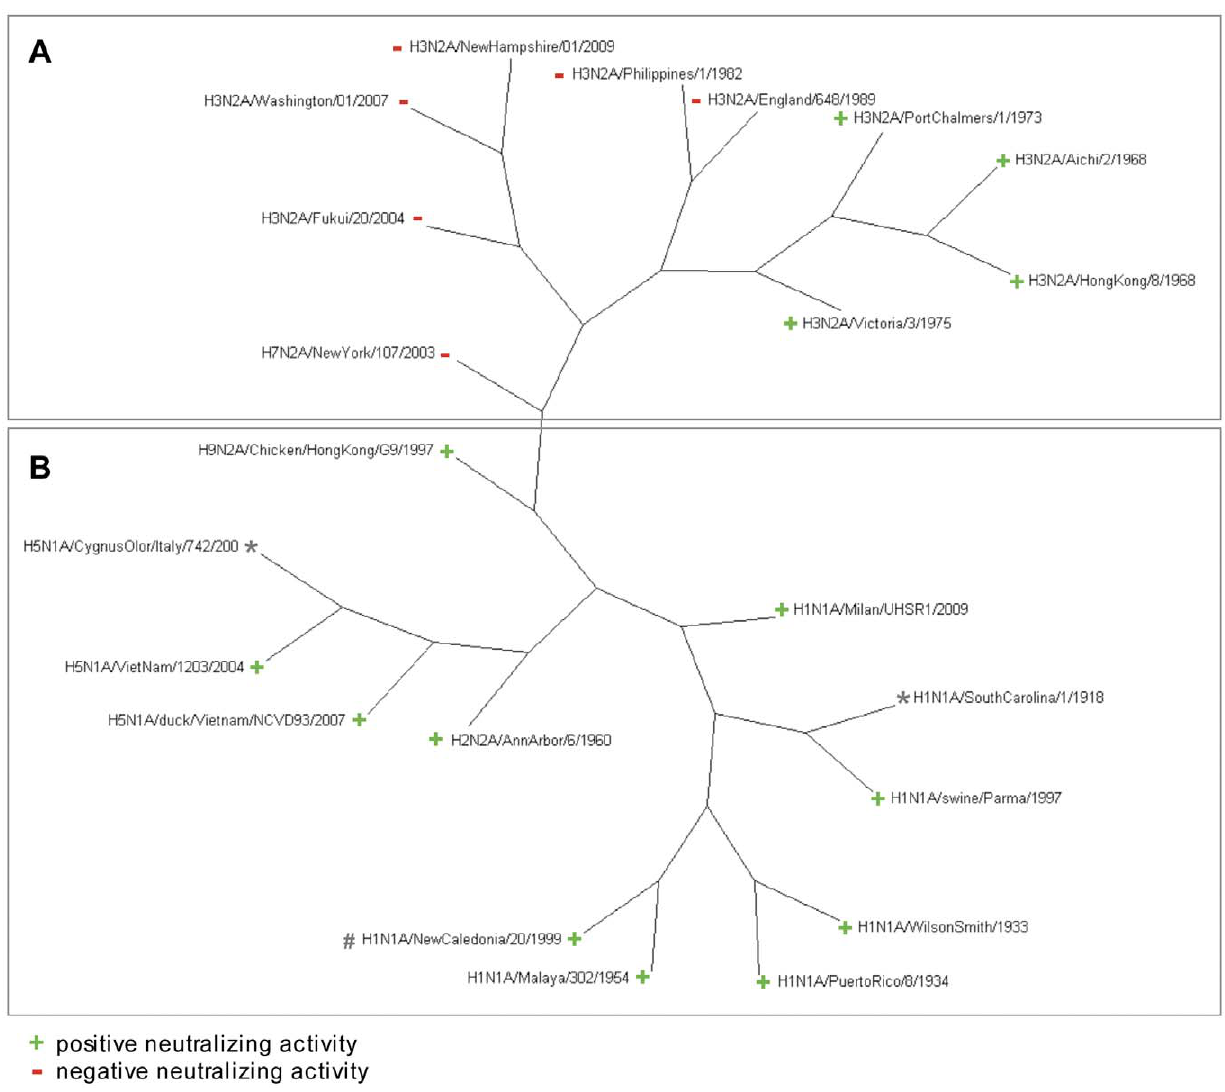
Figure 1. PN-SIA28 Neutralizing activity. Influenza hemagglutinin unrooted phylogenetic tree of the different viral strains tested in neutralization assays with PN-SIA28. Viral isolates belonging to group 1 and group 2 are presented in the box B and box A, respectively. A green ‘ + ’ indicates positive neutralizing activity, a red ‘ 2 ’ indicates negative neutralizing activity. As reported in the text, PN-SIA28 is able to neutralize all of the group 1 strains and is also able to neutralize all of the H3N2 isolates spanning 1968 and 1975. *Recombinant HA from (H1N1) A/South Carolina/1/ 1918 pandemic strain was previously shown to be bound by PN-SIA28 [19,20]. Analogously, recombinant HA from H5N1 A/Cygnus Olor/Italy/742/ 2005 was recognized by PN-SIA28 (data not shown). # H1N1 A/New Caledonia/20/1999 was previously shown to be neutralized by PN-SIA28 as Fab fragment [19,20]. doi:10.1371/journal.pone.0028001.g001 on HA2 (corresponding to His25, His45, Ile361 and Asp362 in H1N1 sequencing numbering) (Figure 2, Figure 4 and Table S1).